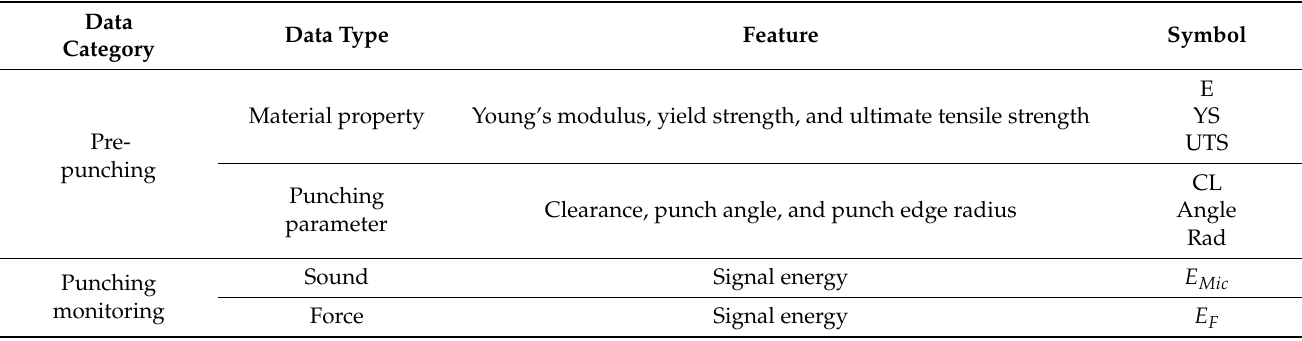
Table 4. List of optimized